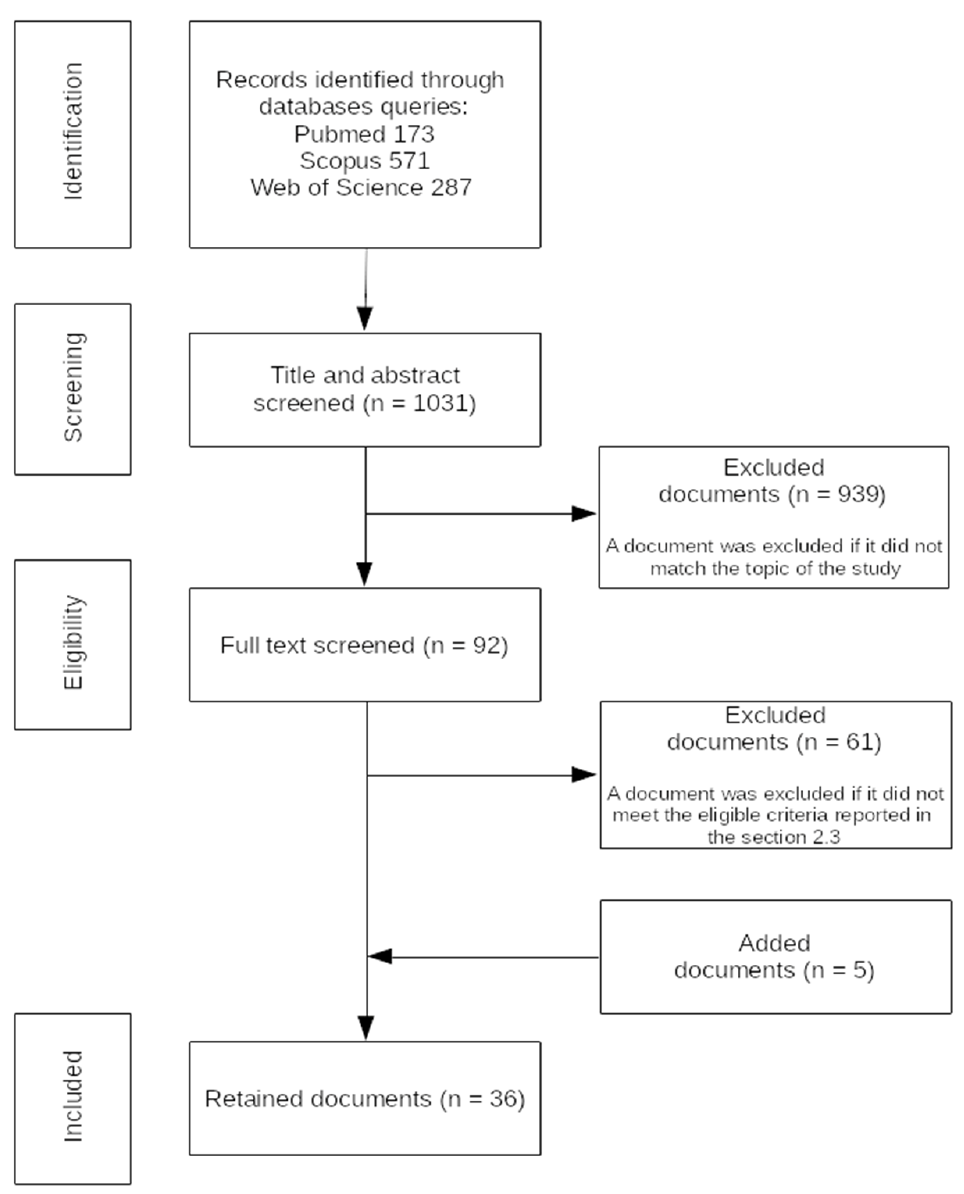
Figure 1. Flow chart of the article selection process.